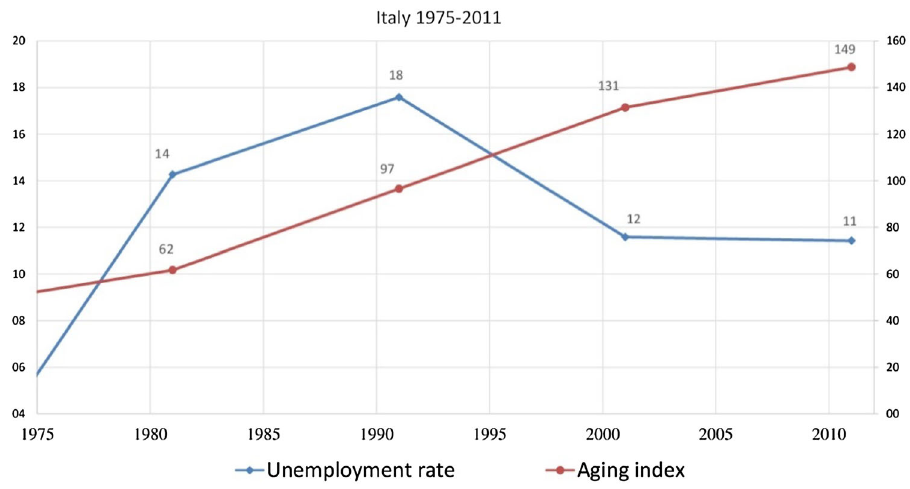
Fig. 2 Trend comparison between unemployment rate (in blue) and aging index (in